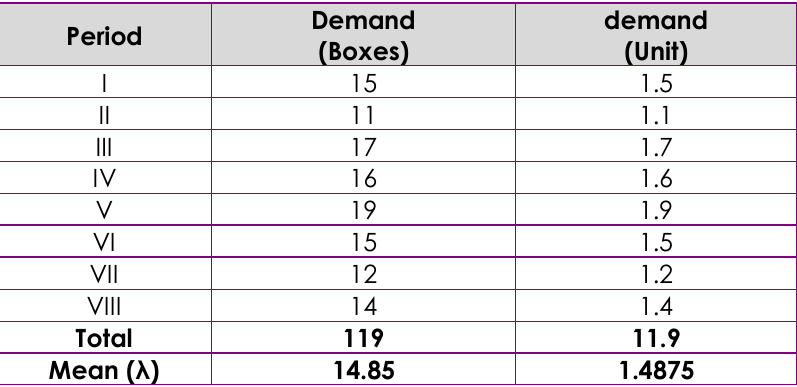
Table 2 Inventory Demand Conversion in